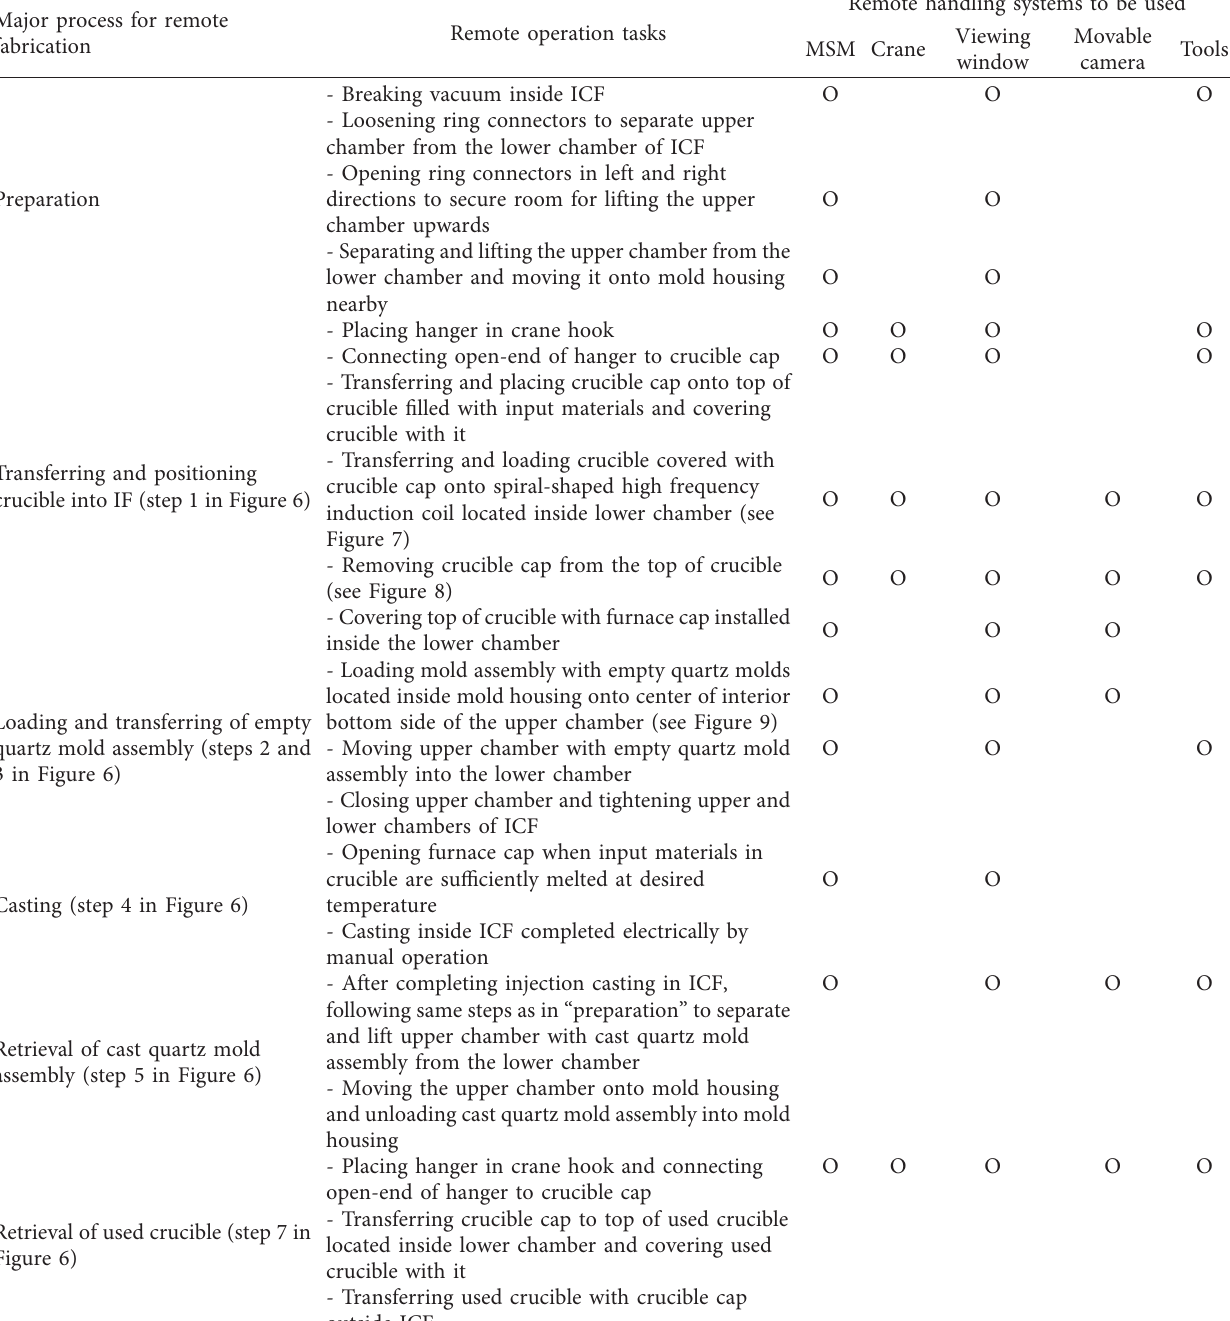
Table 1: Remote operation tasks and remote handling systems for metallic fuel slug